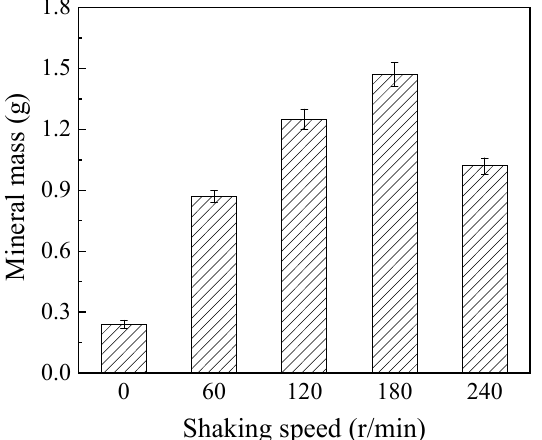
Figure 3. Comparison of the biosynthetic iron hydroxysulfate mineral mass with respect to different hydraulic shear forces.